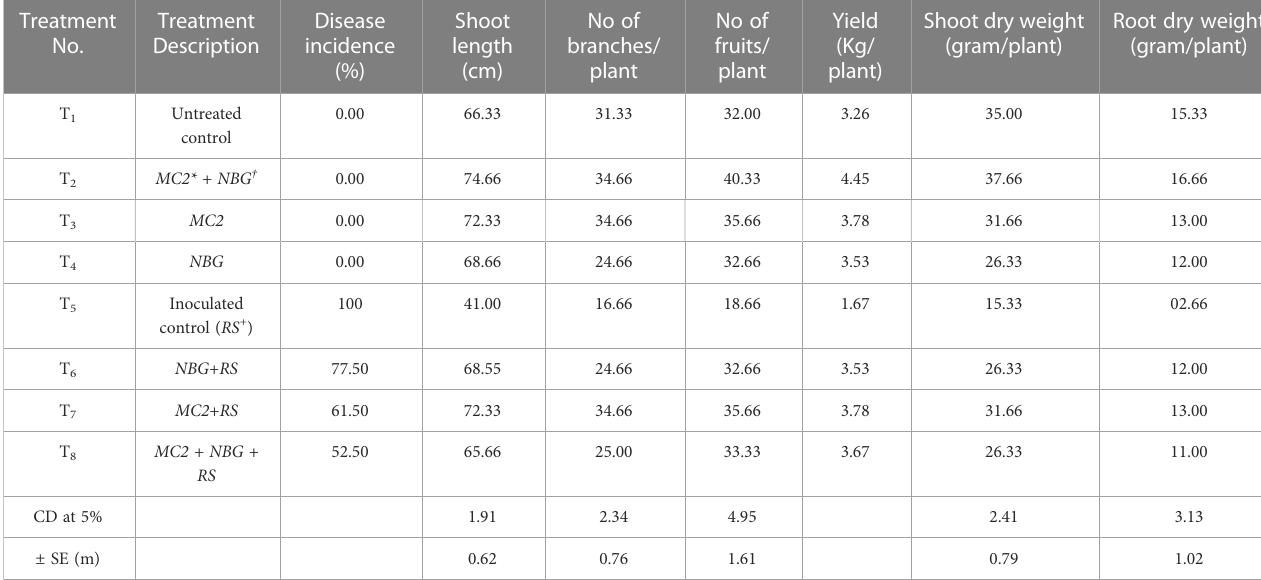
TABLE 8 Disease incidence and growth parameters of eight treatments at harvest. Treatment No.